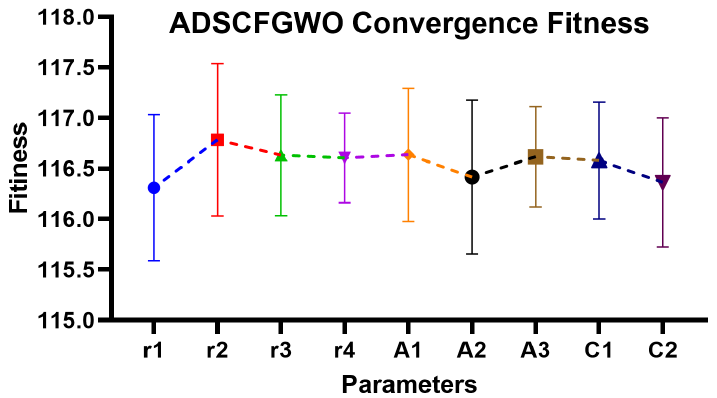
Figure 11. Convergence fitness of ADSCFGWO’s parameters ( r 1 , r 2 , r 3 , r 4 , A 1 , A 2 , A 3 , C 1 , and C 2 ).